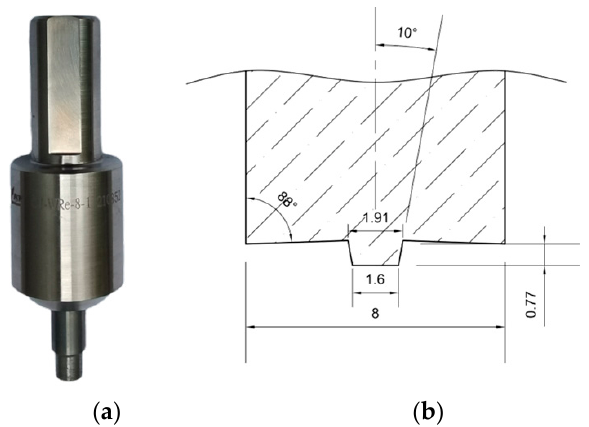
Figure 2. An example of an FSW tool. ( a ) Physical drawing of the tool; ( b ) specific dimensions of the tool (unit: